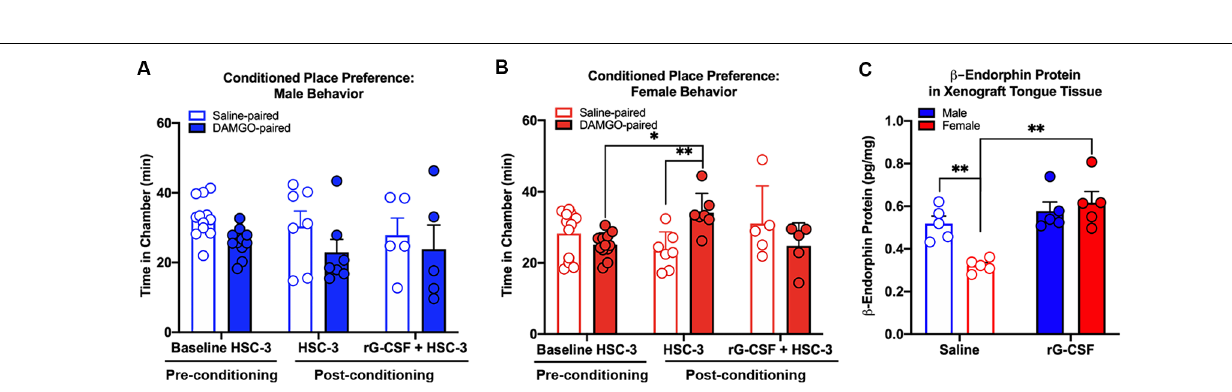
Frontiers in Molecular Neuroscience |